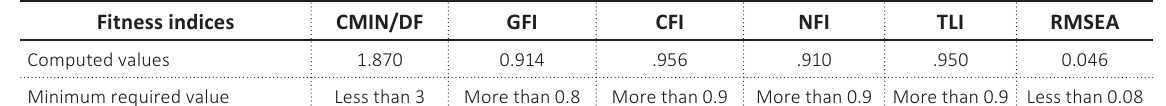
Table 5. Statistical fitness indices